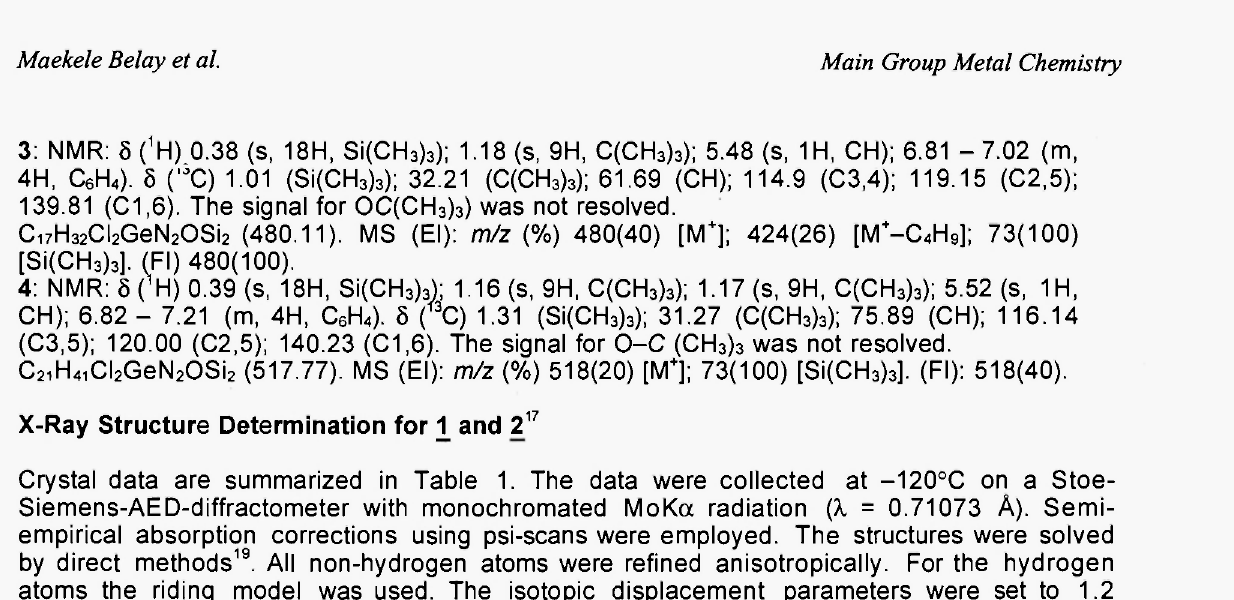
Table 1. Crystal data of 1 and